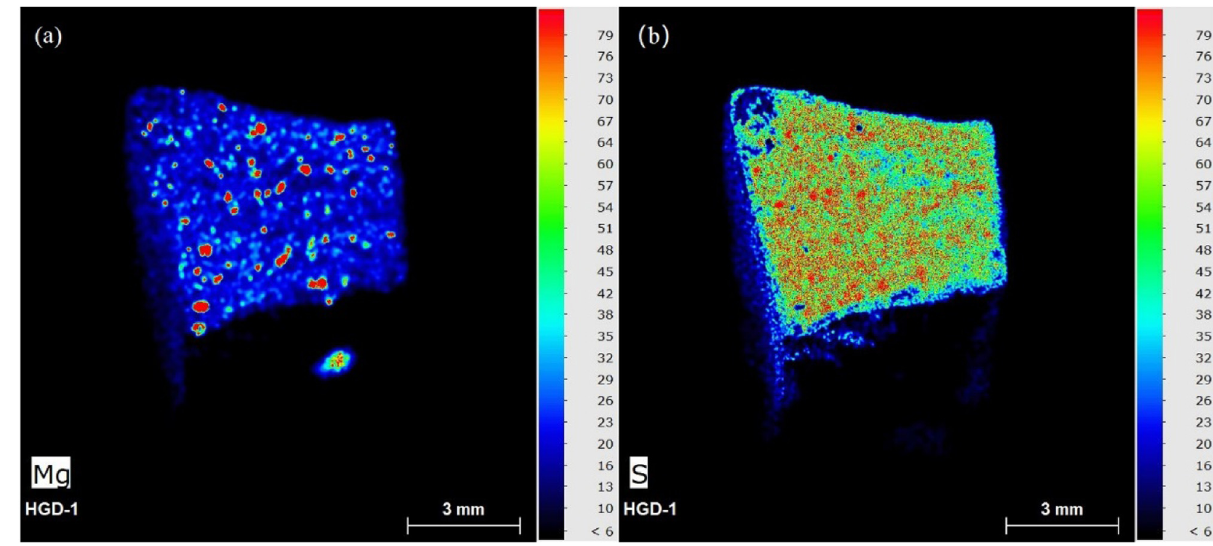
Figure 10: XRF scan result of S3L5: ( a ) Mg and ( b ) S.